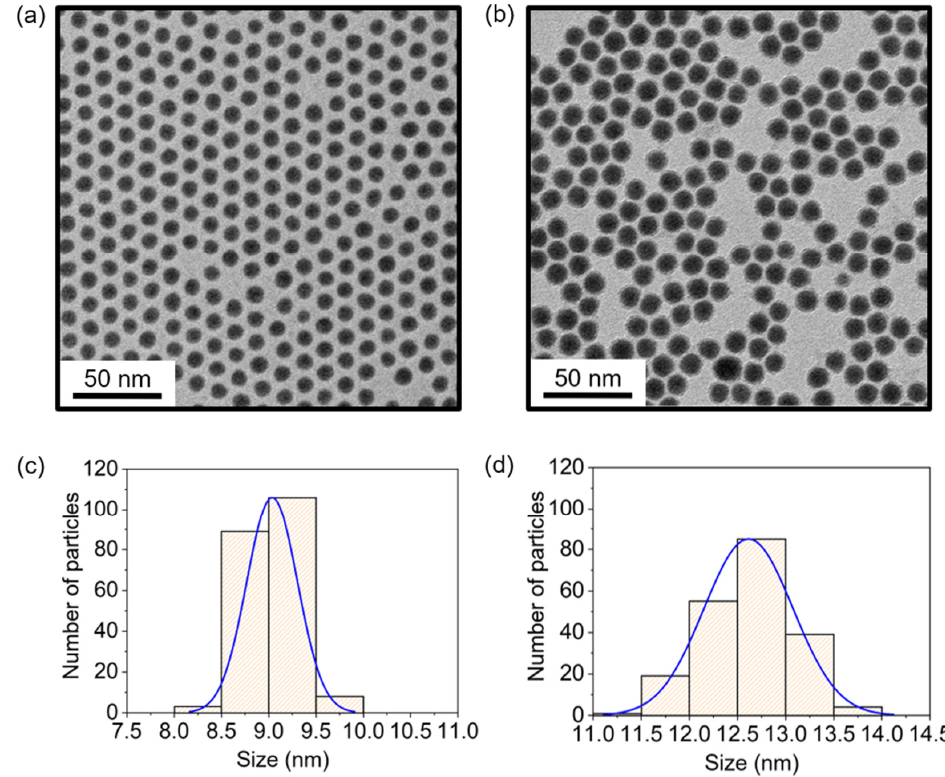
Figure 1. TEM images of ( a ) 9 nm and ( b ) 13 nm nickel nanoparticles obtained at precursor concen- trations of 167 and 200 mM, respectively. Scale bars are 50 nm. The corresponding size histograms are displayed in ( c , d ). The average diameters of the nanoparticles were ( c ) 9.03 nm and ( d ) 12.61 nm. The standard deviations were ( c ) 2.97% (0.268 nm) and ( d ) 3.67% (0.463 nm). Blue lines are Gaussian fitted lines. To ensure the accuracy of size measurement, we measured the sizes of 208 individual particles for each batch.